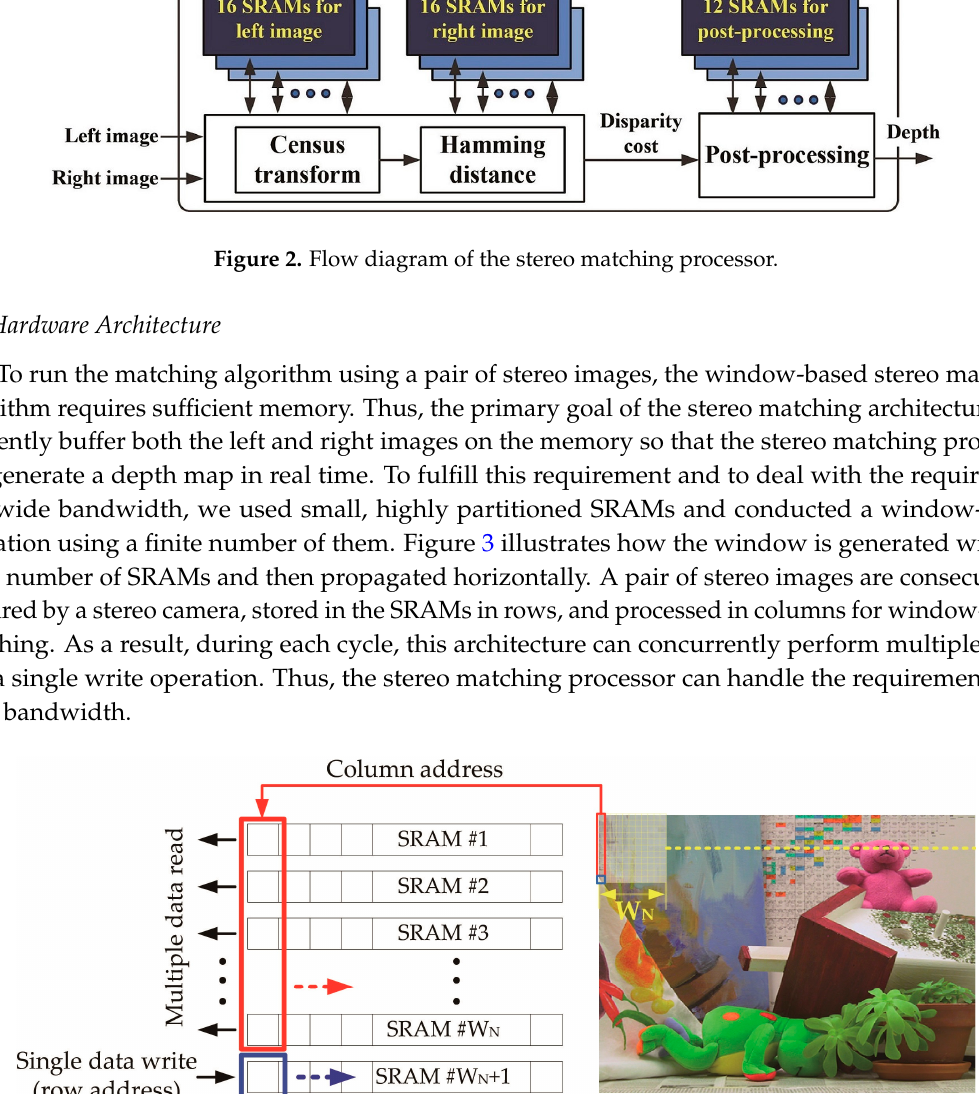
Figure 2. Flow diagram of the stereo matching processor.